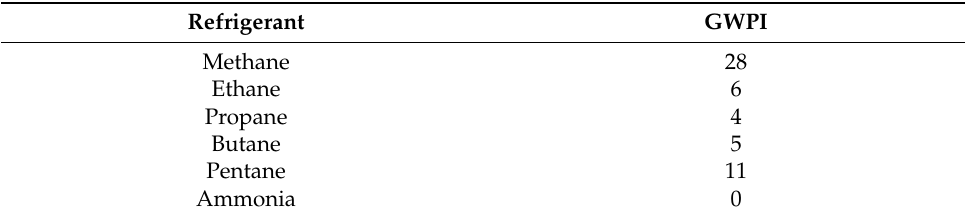
Table 1. Global warming potential index of pure refrigerants